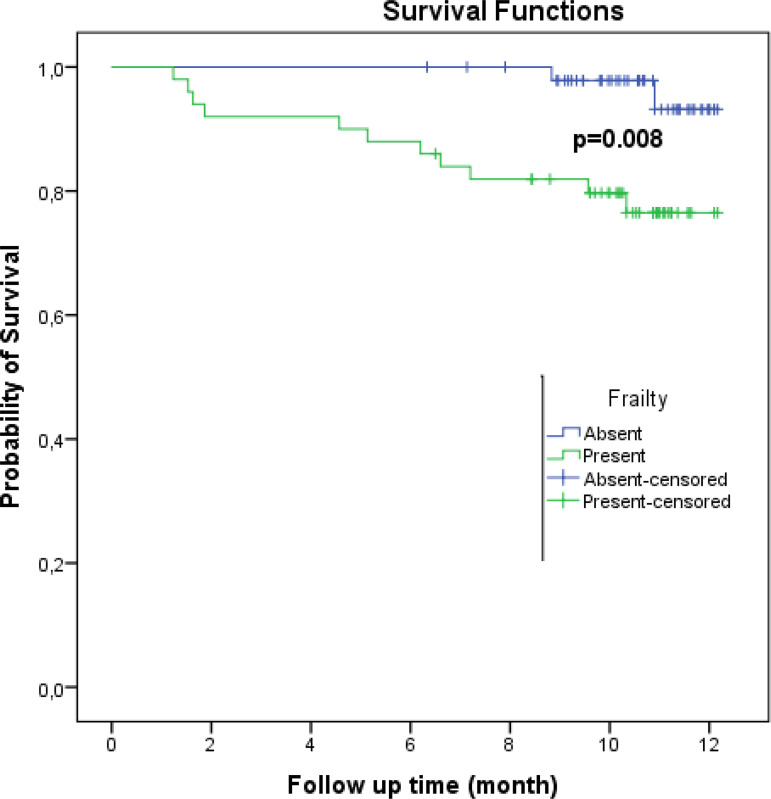
Kaplan-Meier survival curves for the frailty. Survival probabilities and their 95% confidence ıntervals in the time “12 months” are 0.93 (0.83-1.00) for non-frail patients and 0.77 (0.64-0.90) for frail patients.